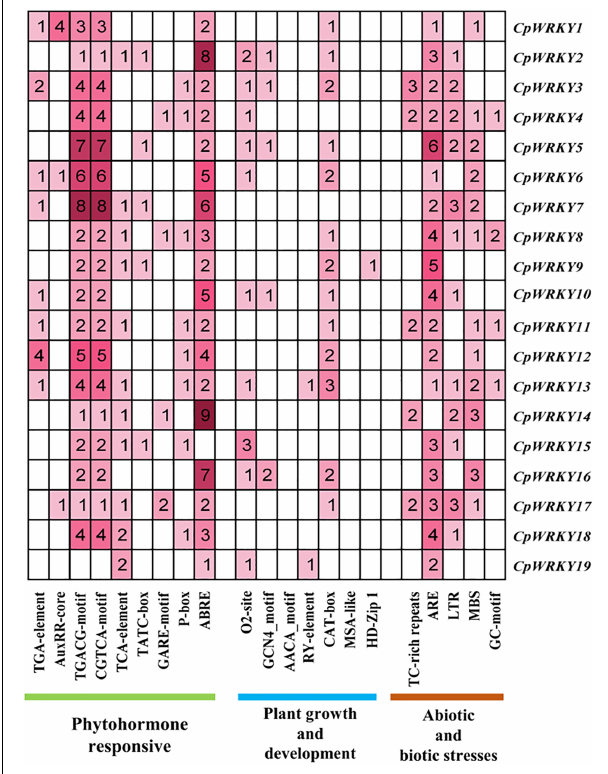
1 and motif 2 was highly conserved, which may be part of the WRKY conserved domain. Motif 8 and motif 9 were two relatively specific motifs, which may enable some WRKY proteins to have specific functions. Gene structure analysis showed that genes, which provides available information for the study of the